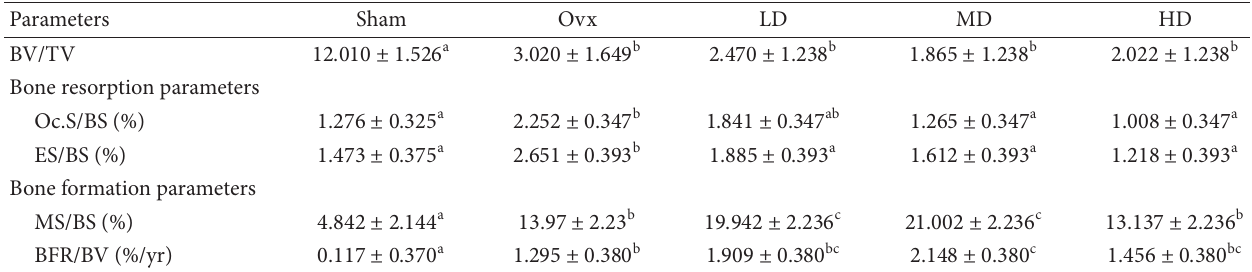
Table 3: Effects of ovariectomy (Ovx) and three doses of vitamin E: low dose (LD, 300 mg/kg diet), medium dose (MD, 525 mg/kg diet), and high dose (HD, 750 mg/kg diet) on the proximal tibial metaphysis cancellous bone cellular activity.